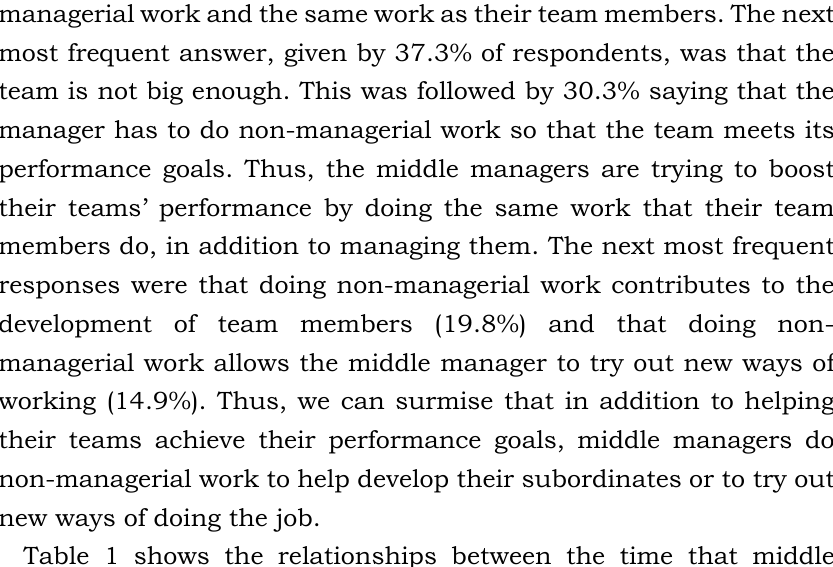
Table 1. Non-managerial work, team performance and number of subordinates Proportion of non- N Team performance Number of managerial work